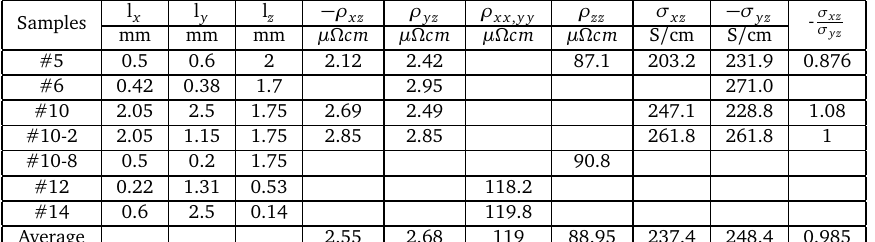
Table S2: Anisotropy of the anomalous Hall effect in different samples at 50 K. Samples